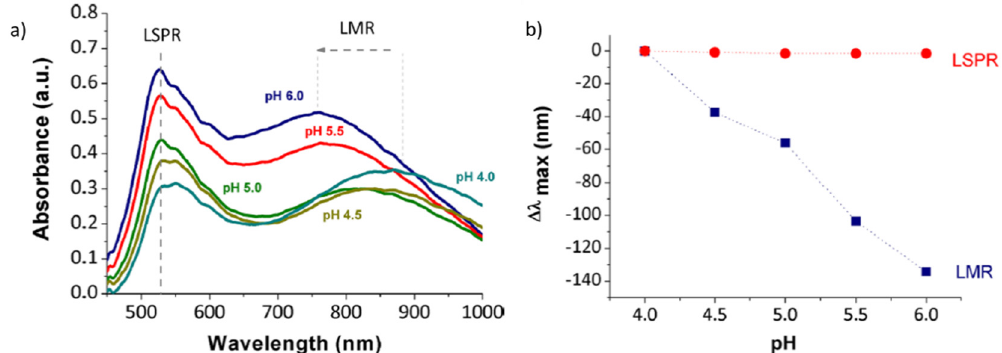
Figure 18. ( a ) Response of the optical fiber sensor for variable pH values from 4.0 to 6.0; ( b ) Shift of the LSPR and LMR bands as a function of the pH changes. Reprinted with permission of [63].